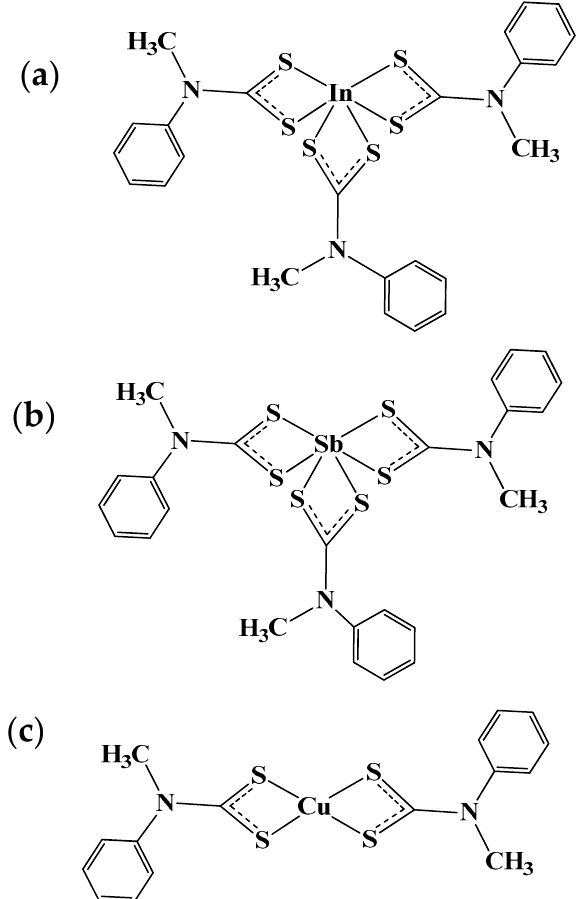
Figure 1. Structures of some of the N -methyl- N -phenyl dithiocarbamate complexes selected for the investigations. ( a ) Indium(III)-tris ( N -methyl- N - phenyl dithiocarbamate). ( b ) Antimony(III)-tris ( N -methyl- N - phenyl dithiocarbamate). ( c ) Copper(II)-bis ( N -methyl- N - phenyl dithiocarbamate) complexes.